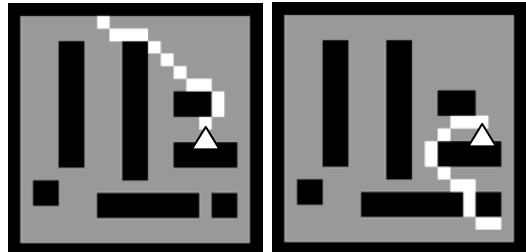
(a) Path of robot R1 (b) Path of Robot R2